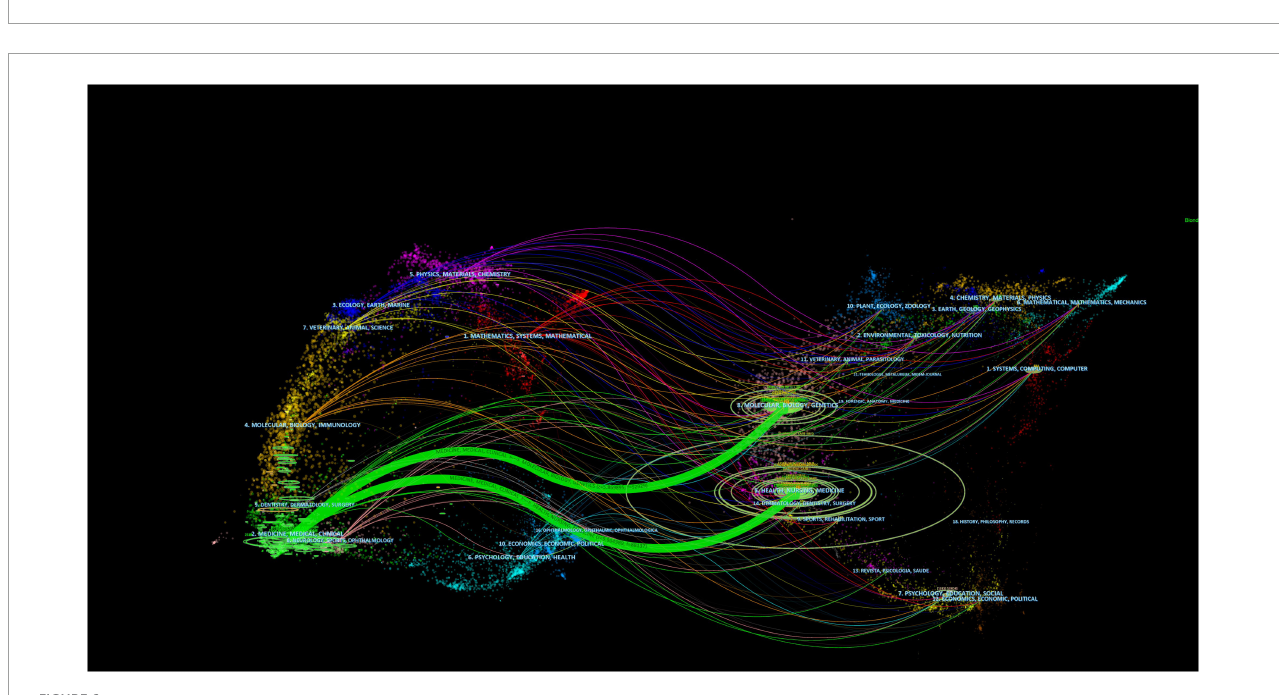
FIGURE6 A dual-map overlap of journals on the application of artificial intelligence in